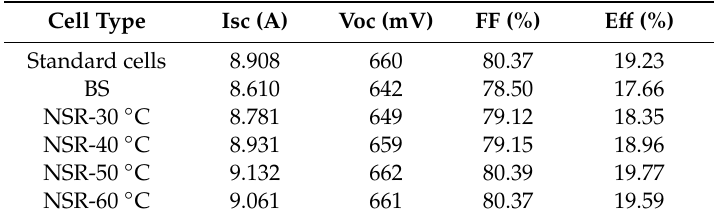
Table 1. Main characteristics of six types of solar cells.